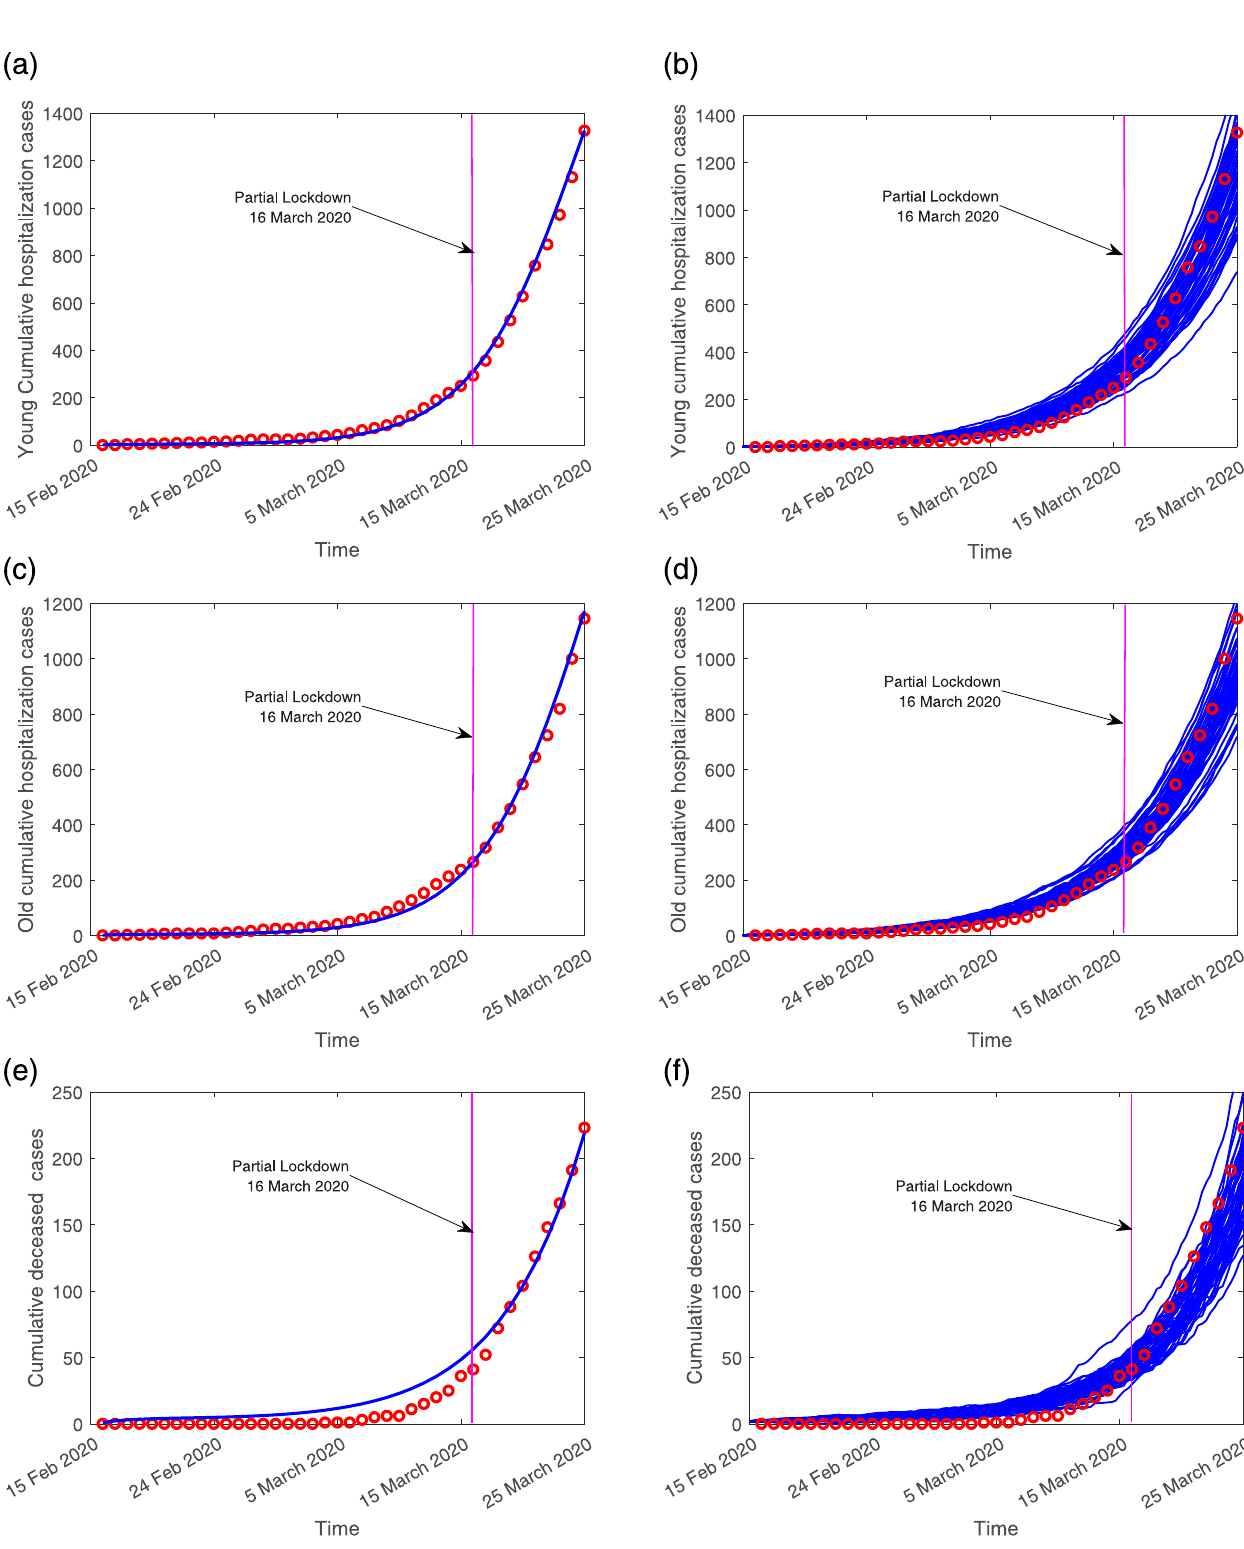
Fig 6. On the left hand side, the deterministic model curve (blue line) and on the right hand side, the stochastic model realizations (in blue), fitting the cumulative empirical data (red dots). In (a-b) the hospitalizations for the young group (0–69 years), in (c-d) the cumulative hospitalizations for the old group (70 years and older) and in (e-f) overall deceased